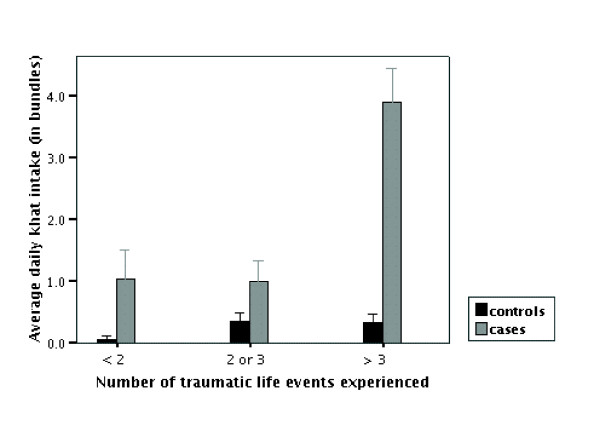
Khat intake and traumatic experiences. Average daily khat intake in bundles (at the age when the case with psychotic symptoms showed onset of symptoms) according to number of traumatic life events. We divided the cases with psychotic symptoms and case controls into three groups according to the number of event types experienced as follows: none or one: 11 cases and 13 controls; two or three: 9 cases and 15 controls; more than three: 11 cases and 14 controls. Bars indicate mean and standard error.